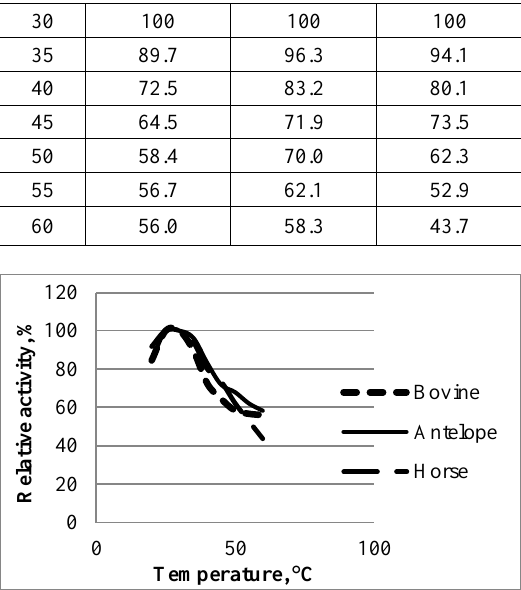
Figure1. Temperature influence on enzyme activity Table 3. pH influence on enzyme activity